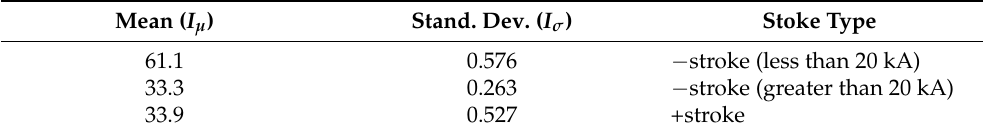
Table 1. Logarithmic normal distribution of lightning current parameters [23].